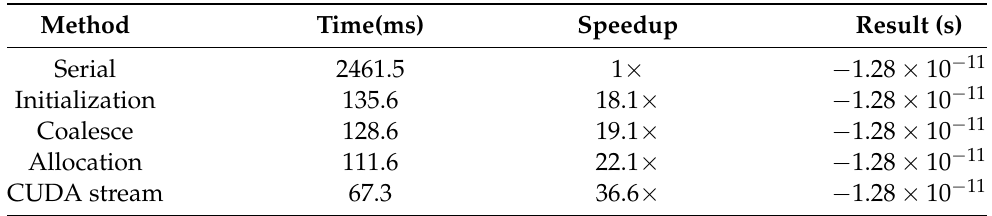
Table 2. Speedup after using different optimization strategies (Result: The result of the residual delay of one channel